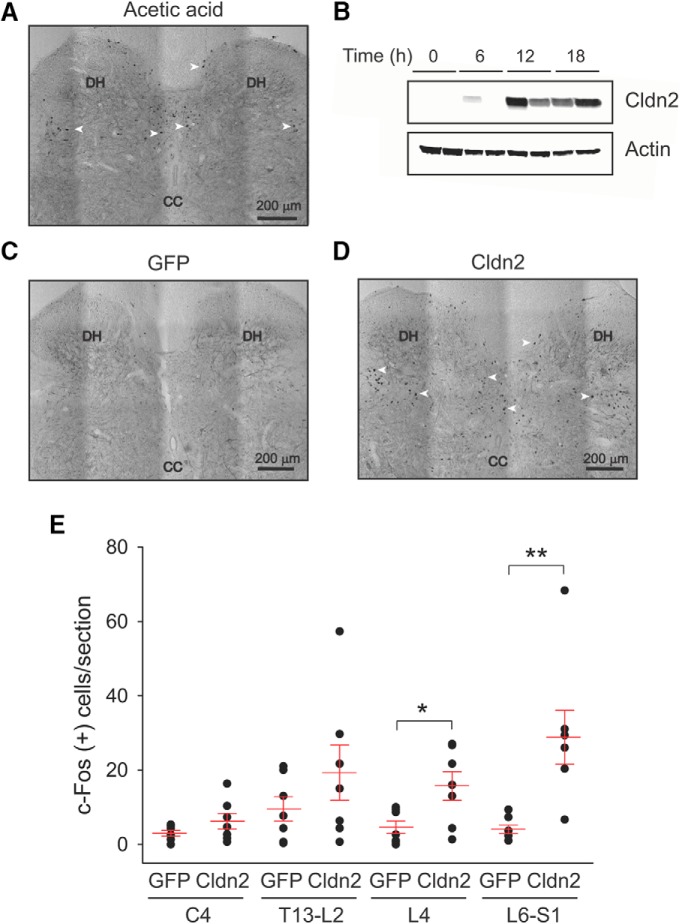
Overexpression of Cldn2 in the urothelium increases the number of c-Fos-immunoreactive cells in spinal cord segments receiving bladder input. A, Micrography of an L6-S1 spinal cord section from a rat infused with 1% acetic acid for 2 h showing the distribution of c-Fos-positive neurons in the dorsal horn (DH). Immunoreactive neurons were distributed throughout the medial DH, dorsal commissure, and sacral parasympathetic nucleus. Arrows indicate areas with c-Fos-positive cells. B, Time course of expression of Cldn2 following in situ transduction with AdCldn2. Urothelial samples were collected 6, 12, and 18 h after in situ transduction. Nontransduced rats served as controls for this experiment (time 0 h). Whole-cell lysates were subjected to immunoblot with an anti-Cldn2 antibody or an anti-actin antibody. C, Micrography of an L6-S1 spinal cord section from a rat transduced with AdGFP. D, Micrography of an L6-S1 spinal cord section from a rat transduced with AdCldn2. Arrows indicate areas with c-Fos-positive cells. c-Fos-positive cells were distributed throughout the medial DH, dorsal commissure, and sacral parasympathetic nucleus. E, Number of c-Fos-positive neurons per section in spinal cord segments from rats transduced with AdGFP and AdCldn2. Statistically significant differences between experimental conditions are indicated as *p < 0.05 and **p < 0.01 (n = 7, Mann-Whitney nonparametric test).